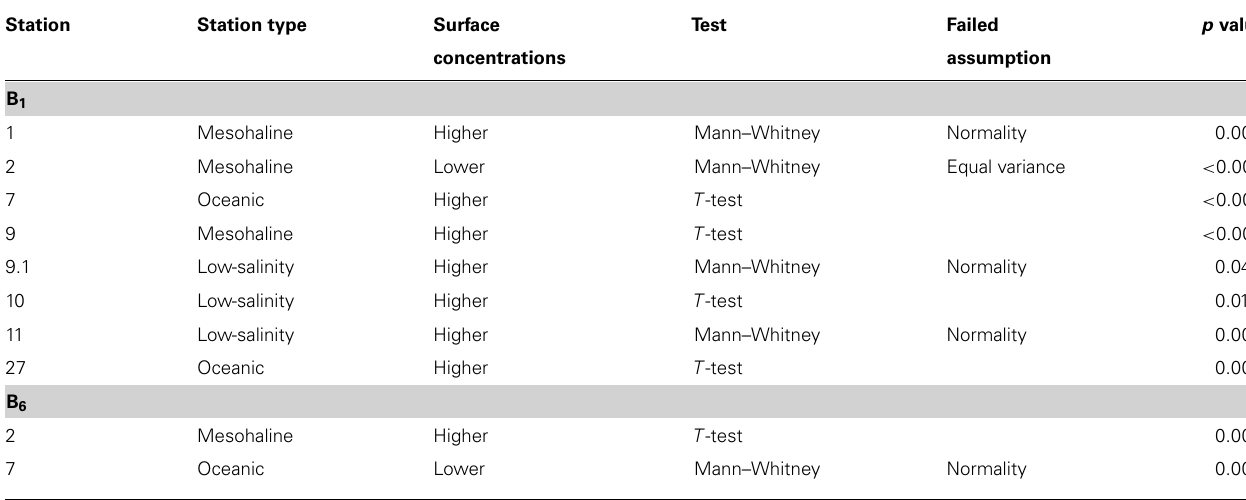
Table 1 | Statistical test results comparing B vitamin concentrations at surface depths with below surface or halocline depths.Vitamin B 1 followed by B 6 , the specific statistical test, failed T -test assumptions, and p value for each station is listed.